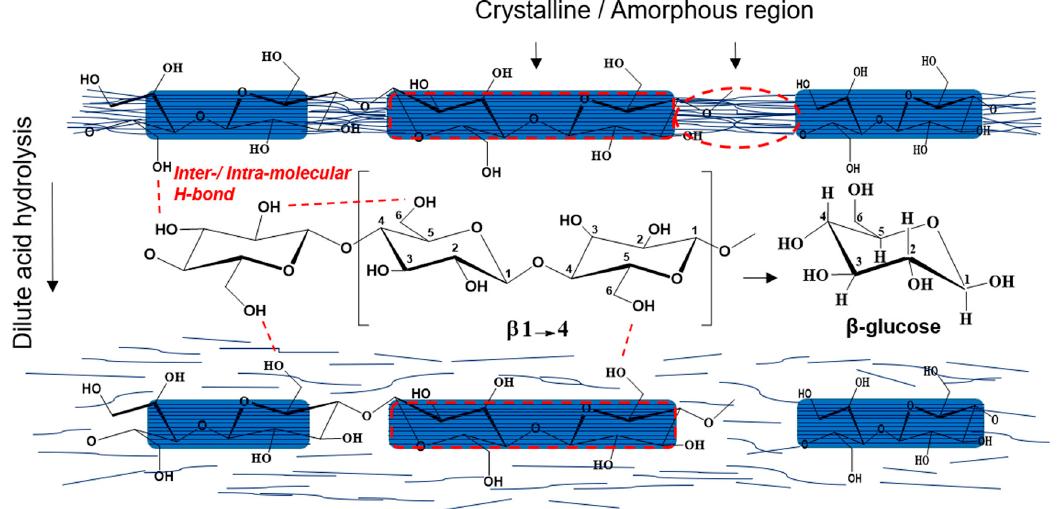
Figure 1. Hypothetical schematic of dilute acid pretreatment process to extract the crystalline regions of cellulose from amorphous domains. In the middle, the configuration of cellulose repeating unit with the β -(1,4) glycosidic linkage under the effect of intra/intermolecular hydrogen bonding is denoted. Reproduced with permission from Reference [36]. Copyright ©2019, Elsevier.